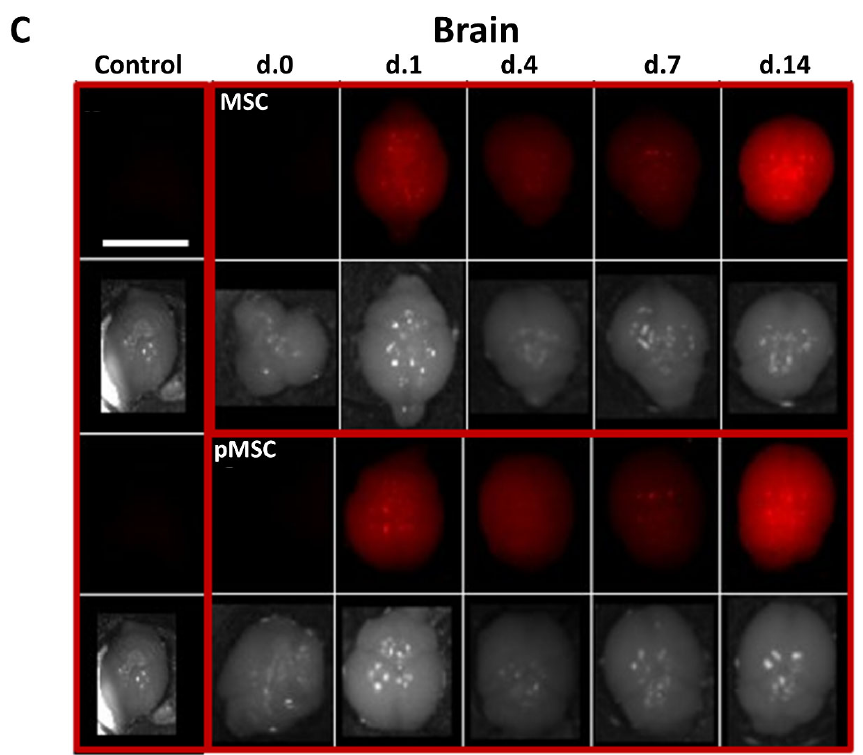
Figure 7. MSC engraft to various organs following intravenous injection in mice. DiR labeled naïve and polarized MSC (2 × 10 5 ) were injected into the tail vein of 3-month-old mice. Labeled cells were detected using the Maestro in vivo imaging system at days 0, 1, 4, 7, and 14 following the injection. Imaging was performed and presented for the following dissected organs: ( A ) lungs (scale bar = 1 cm), ( B ) liver (scale bar = 3 cm), and ( C ) brain (scale bar = 1.5 cm). In each organ, the negative control (vehicle injected animal) is presented in the left rectangle, naïve MSC engrafted organ in the upper right and polarized MSC (pMSC) in the lower right rectangle. In each rectangle, the upper photographs represent fluorescent detection of DiR signal in the organ and the corresponding lower photograph, a visual light image of the same organ.